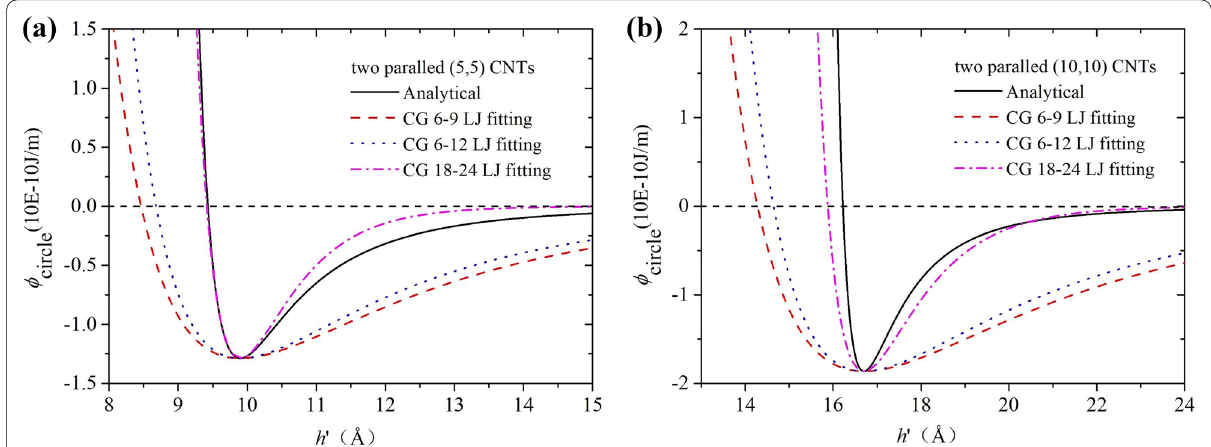
Figure 11 Analytical cohesive energy of two parallel ( a ) (5,5) and ( b ) (10,10) CNTs and the fitting curves [61]